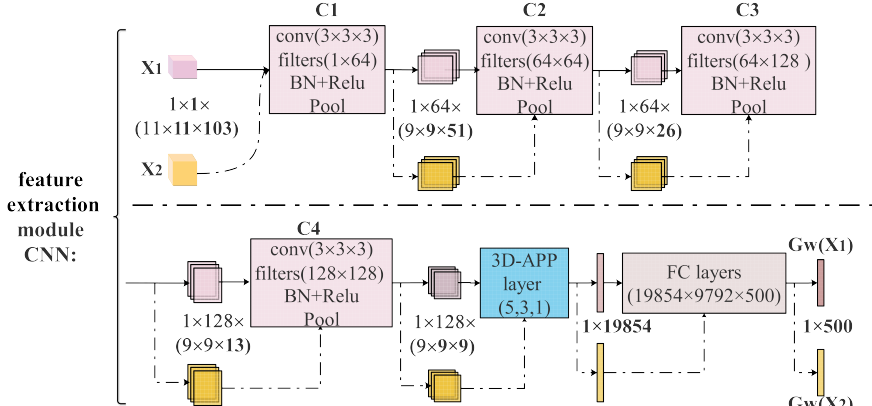
Figure 6. Architecture of our feature extraction with a 3D adaptive spatial-spectral pyramid pooling layer. It contains four 3D CNN blocks, a 3D ASSP layer and three fully connected layers. The input of the feature extraction is a 3D sample-pair and output are two features with the same